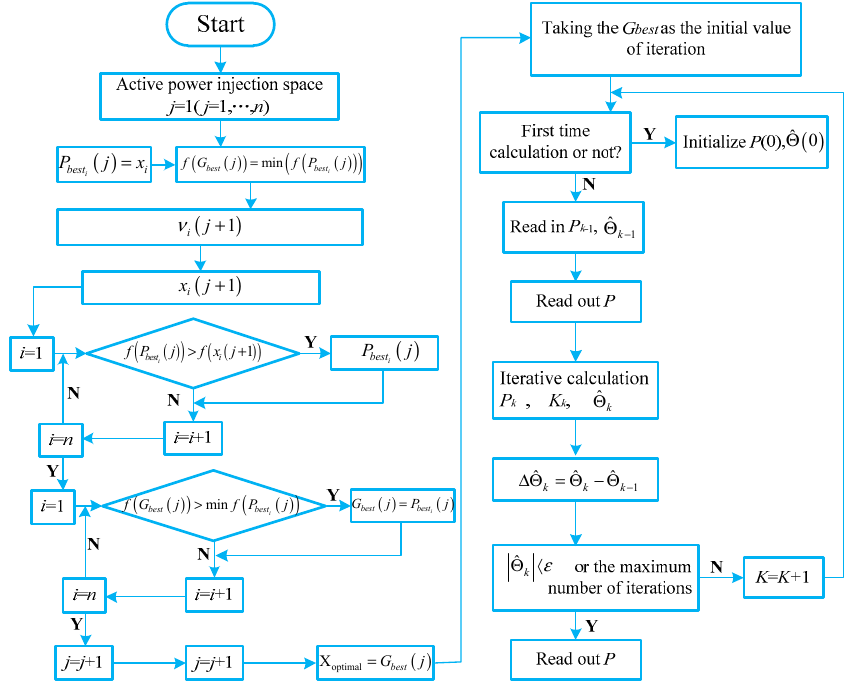
Figure 6. The flowchart of the AVURPSO-RLS algorithm.